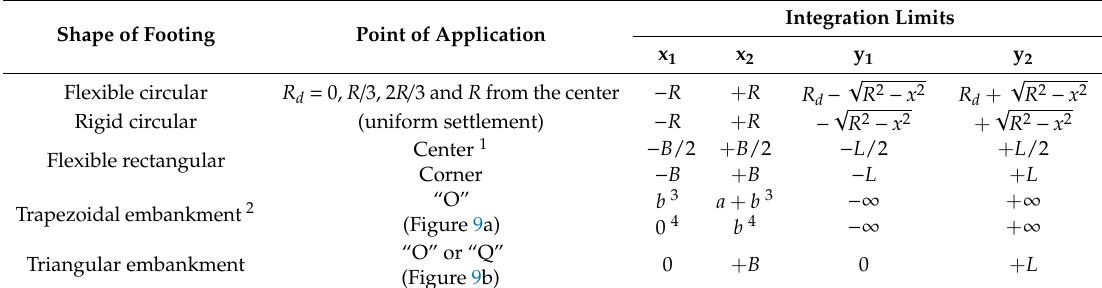
Table 1. Integration limits for Equation (4).